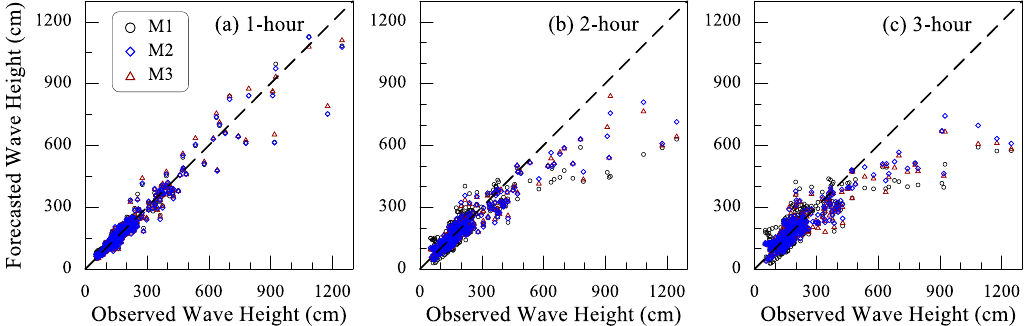
Figure 4. Forecasting results with lead time of ( a ) 1, ( b ) 2, and ( c ) 3 h for Longdong.